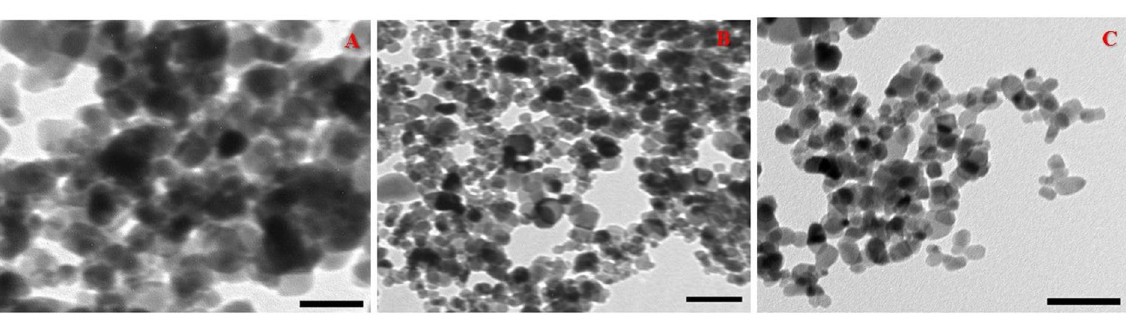
Figure 2. TEM of TiO 2 NPs prepared at different pH values; ( A ) pH = 1.6, ( B ) pH = 7.0 and ( C ) pH = 10. The scale bar is 50 nm.